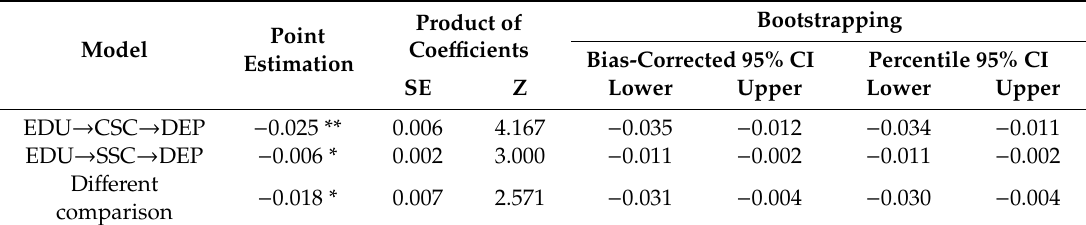
Table 3. Mediation of e ff ect of education on depression through cognitive social capital and structural social capital. EDU: education; CSC: cognitive social capital; DEP: depression; SSC: structural social capital. Product of Point Model Coe ffi cients